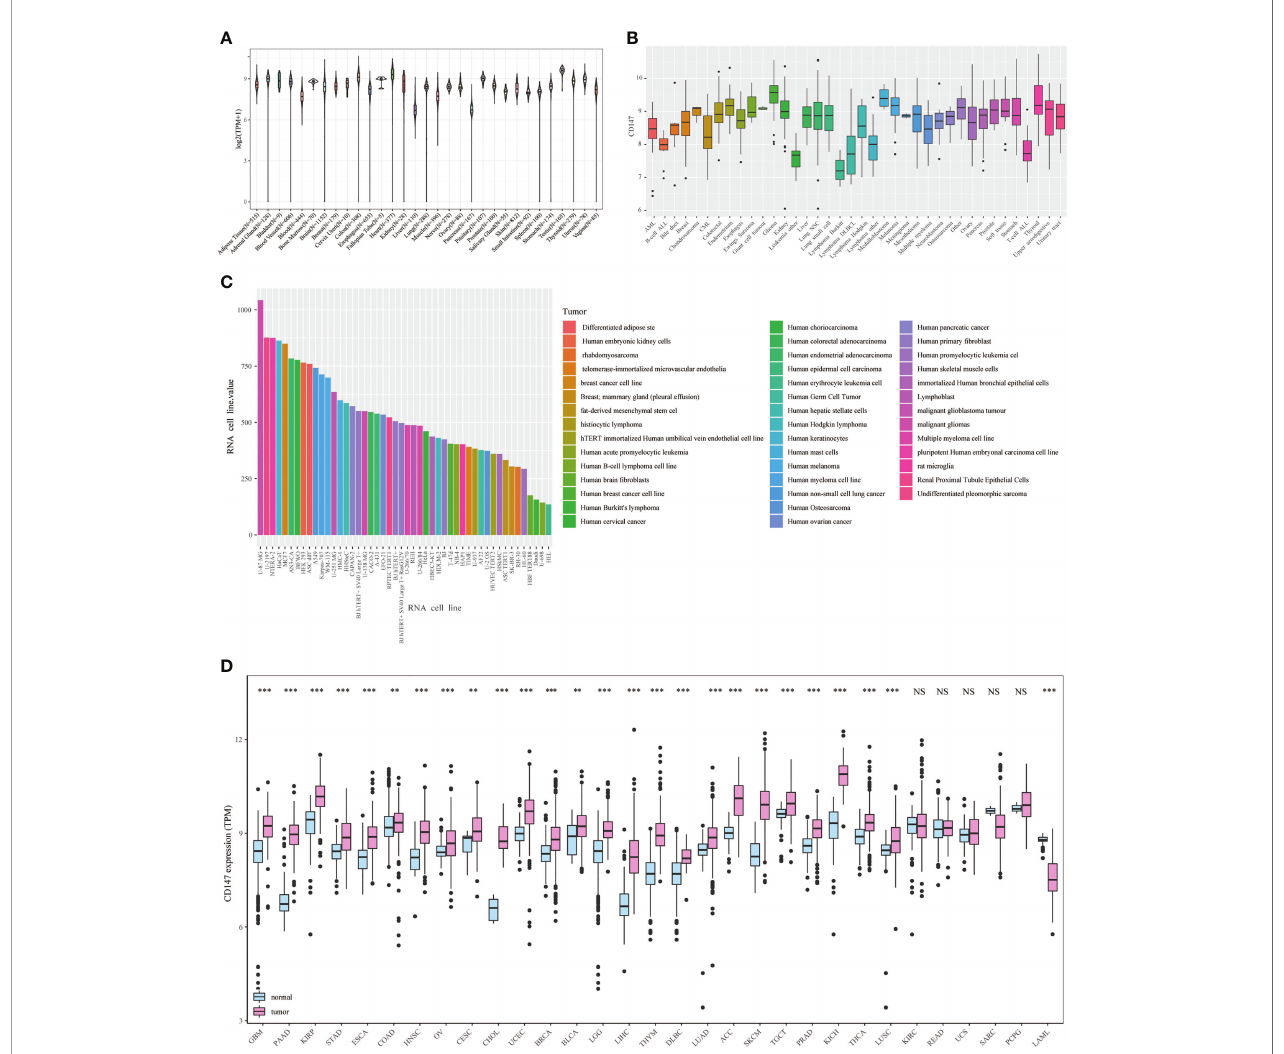
FIGURE 2 | Expression landscape of CD147 in the normal and tumor samples. CD147 levels in 31 human tissues from the GETx dataset (A) . CD147 levels in tumor cell lines from the CCLE dataset (B) . CD147 levels in 43 tumor cell lines from the HPA dataset (C) . CD147 expression analyzed by TCGA and GETx datasets (D) . **p < 0.01, ***p < 0.001, NS, no signi fi cant